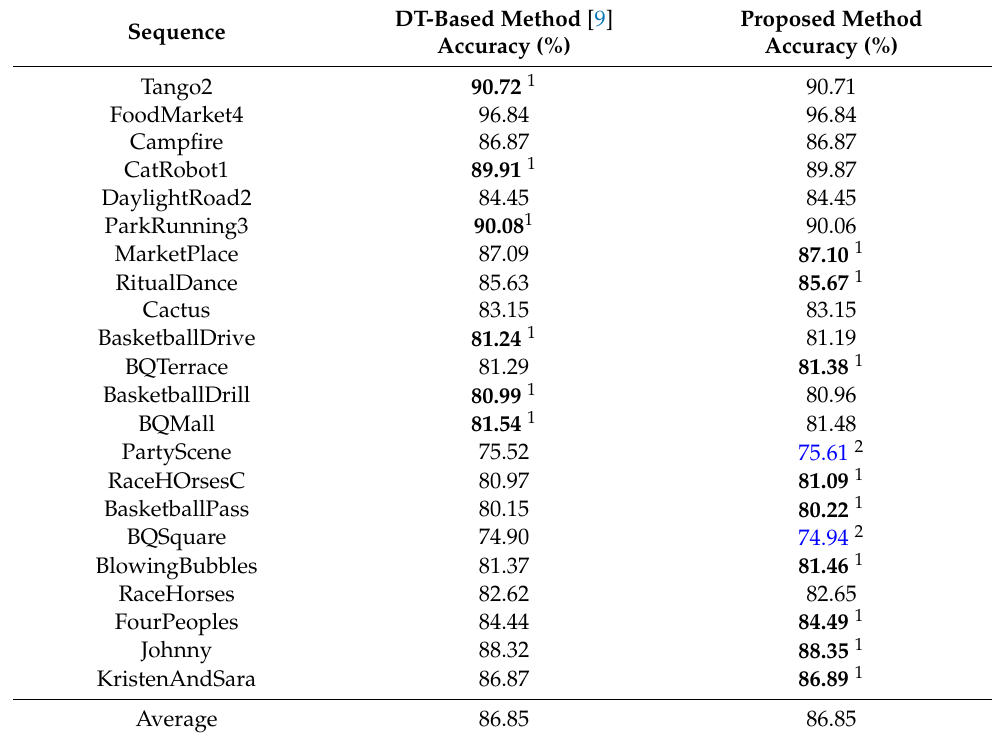
Table 6. Accuracy of the DT-based and proposed method regarding the TT_H decisions.